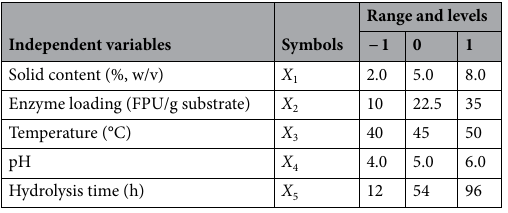
Table 1. Independent variables and levels in the Box–Behnken